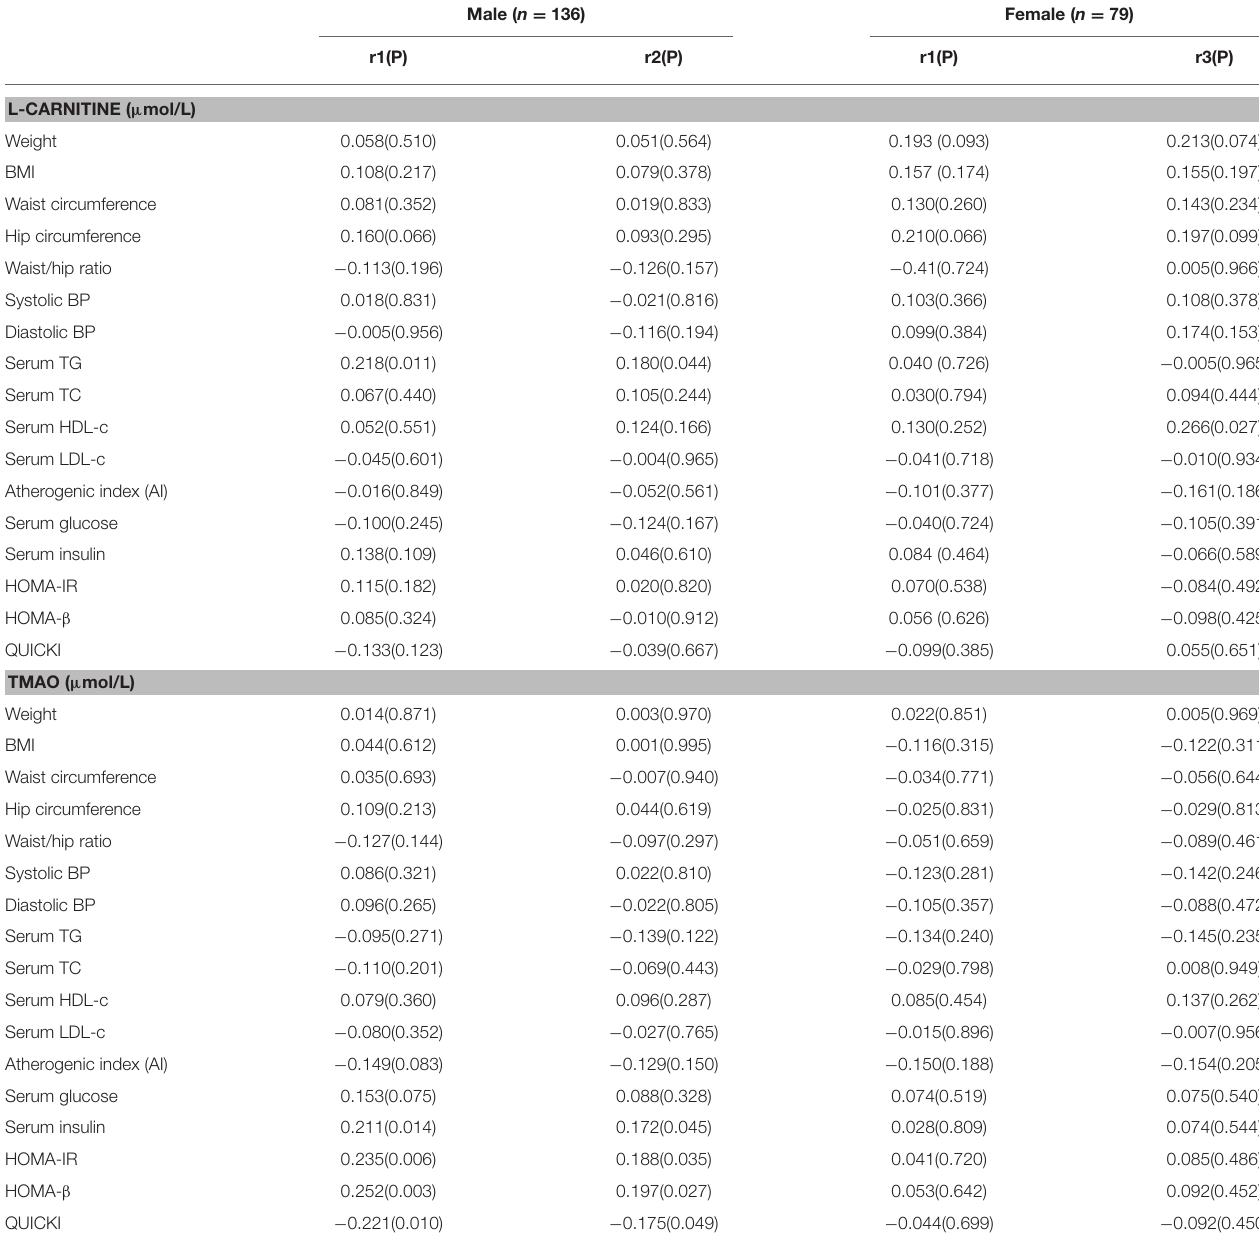
TABLE 6 | Partial correlations between serum L-carnitine, TMAO levels with components of MS in females and males with